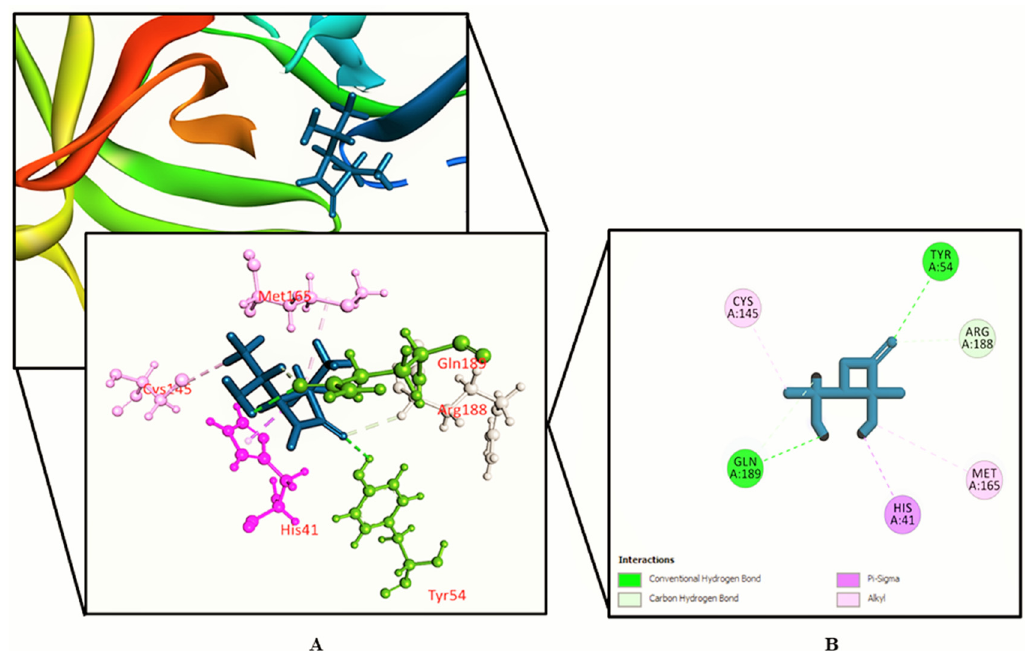
Figure 3. Azetidin-2-one 3,3-dimethyl-4-(1-aminoethyl) binding the SARS-CoV-2 receptor (PDB ID: 6LU7). ( A ) A 3D representation and ( B ) 2D representation. Hydrogen bonds are displayed as green balls and sticks, hydrophobic bonds (Pi–Pi/Pi–sigma/amide–Pi interactions) are displayed as violet balls and sticks, hydrophobic bonds (Pi–alkyl/alkyl interactions stacking) are displayed as pink balls and sticks, hydrophobic bonds (Pi–sulfur) are displayed as gold balls and sticks, and carbon–hydrogen bonds are displayed as white balls and sticks.